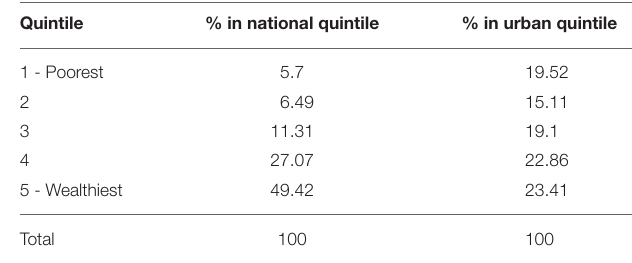
TABLE 4 | Distribution of Respondents by National and Urban Wealth Quintile (n = 2157) a . Quintile % in national